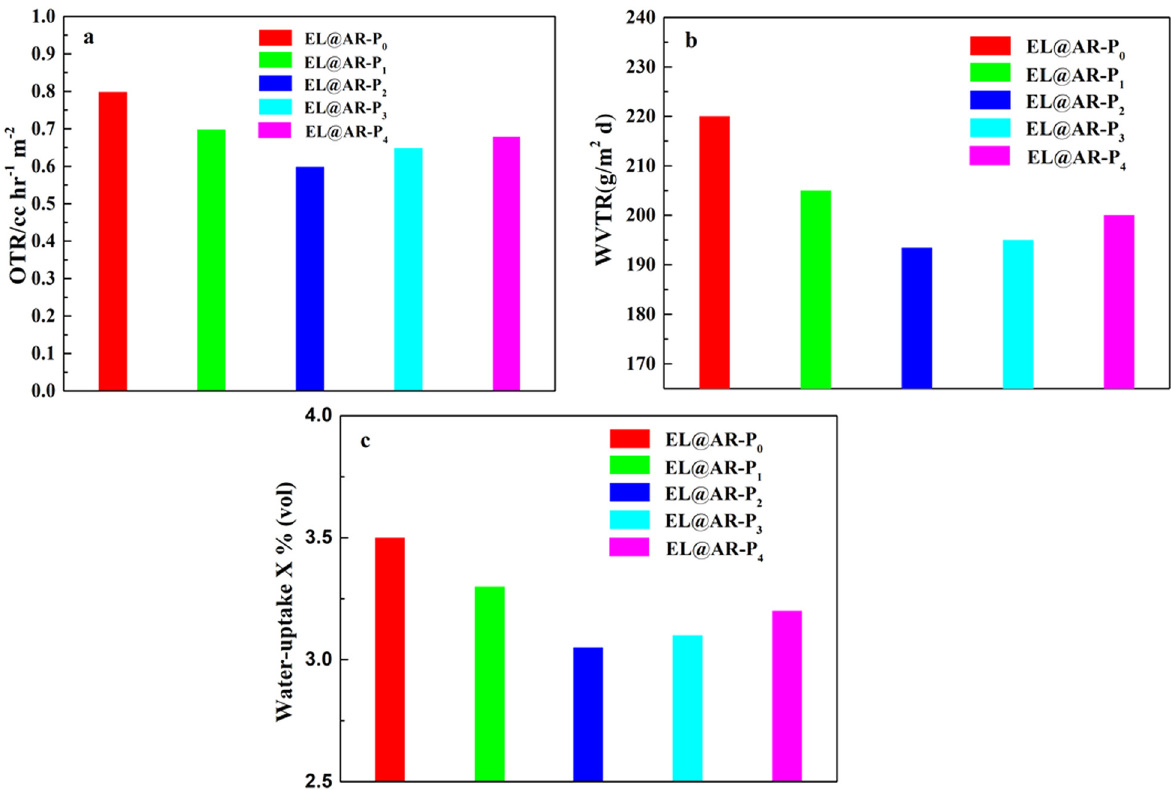
Figure 5: Oxygen ( a ) and water vapor ( b ) transmission rates of the EL@AR - P coatings, water - uptake rate of the EL@AR - P coatings ( c ) .